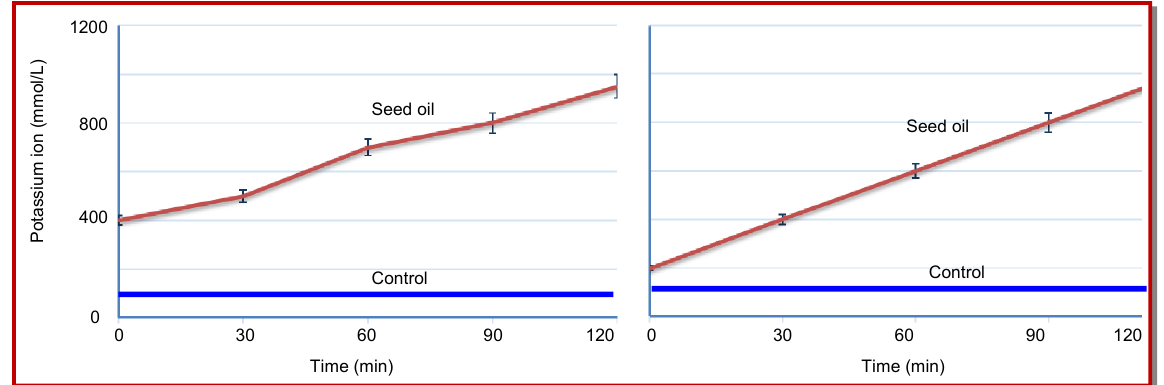
Figure 1: Effect of the C. bonducella seed oil on the leakage of potassium ions from the tested food-borne pathogenic bacteria L. monocytogenes (a) and E. coli